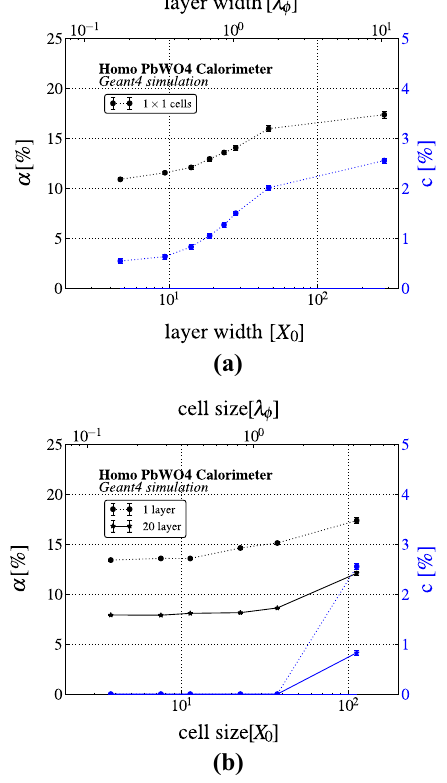
Fig. 7 Values of the parameters α (black line) and c (blue line) in = α ⊕ c as a function of the a the energy resolution function σ E (cid:5) E (cid:6) E longitudinaland b transversegranularity.Intheupperplot,notransverse segmentation is used, while on the bottom, two different longitudinal segmentations are shown: 1 layer (dashed lines) and 20 layers (solid